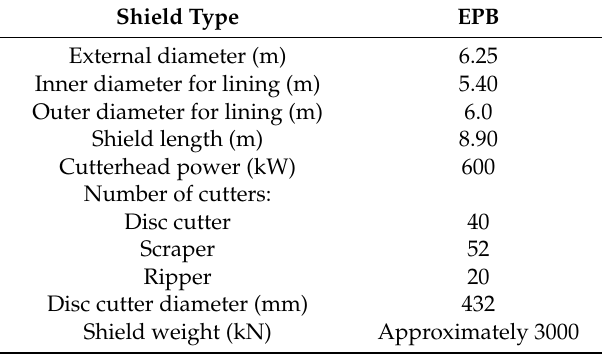
Figure 3. Location of the construction site, ( a ) map of Guangzhou City, ( b ) metro line 9. Table 1. Summary of the main specifications for the earth pressure balance (EPB) shield.